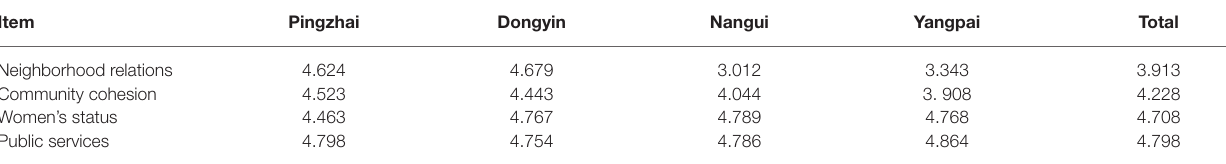
TABLE 7 | Means analysis of social empowerment perception. Item